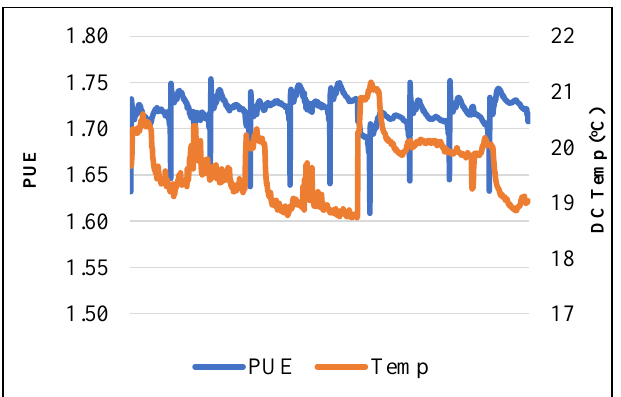
Figure 7. Predicted data DC PUE vs temp.